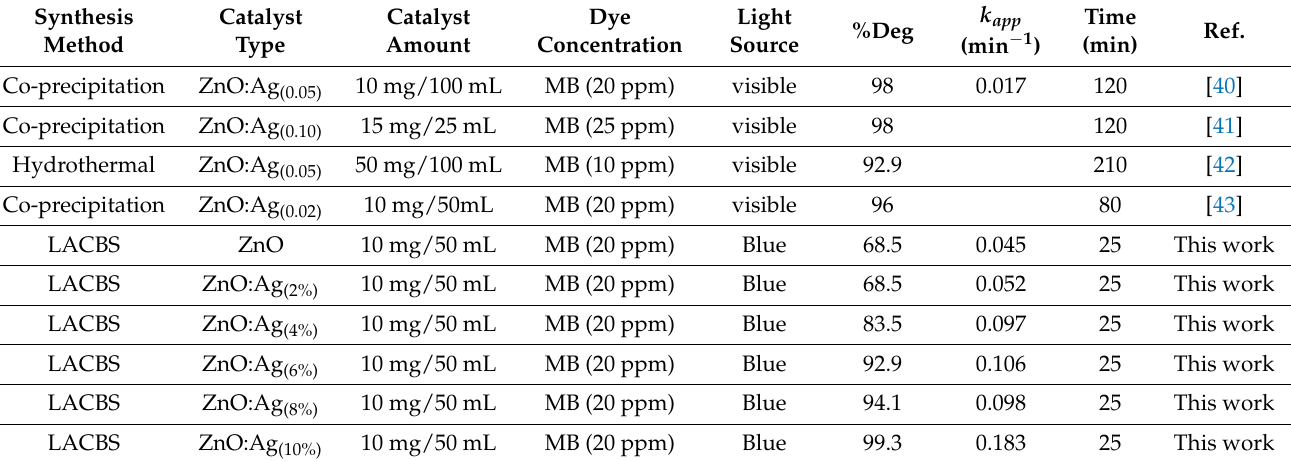
Table 3. Comparison between efficiencies of different catalyst systems with previous studies.